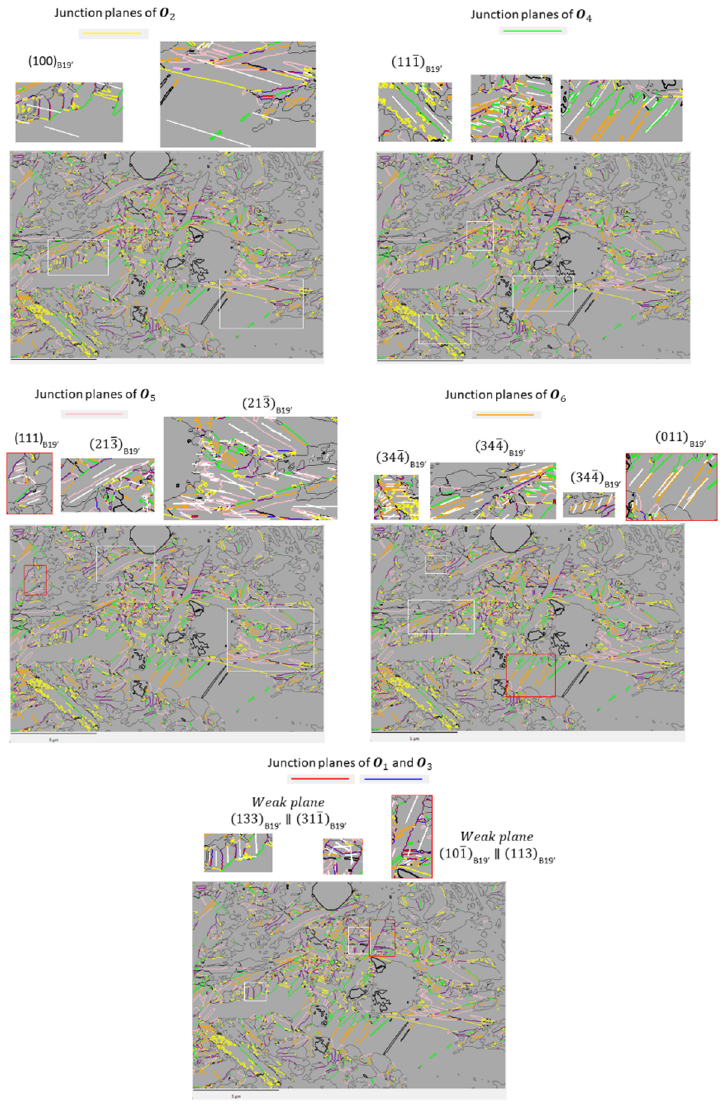
Figure A2. TKD map of a fully martensitic B19 ′ NiTi alloy with the junction boundaries colored as function of the operators, such as in Figure 5.